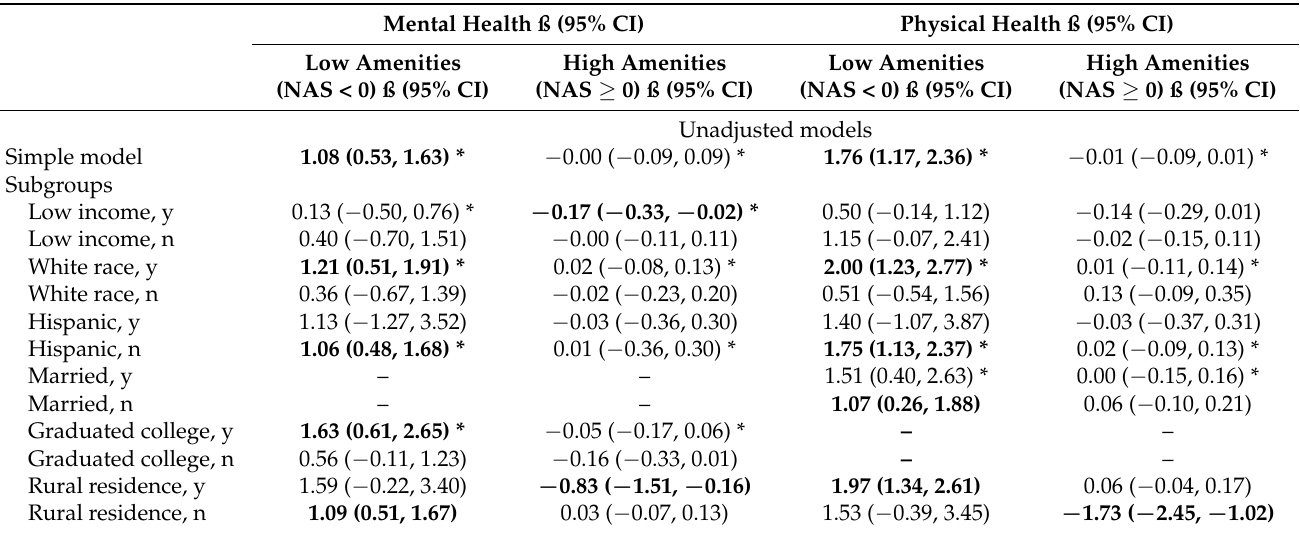
Table 2. Unadjusted piecewise spline regression overall and subgroup models.